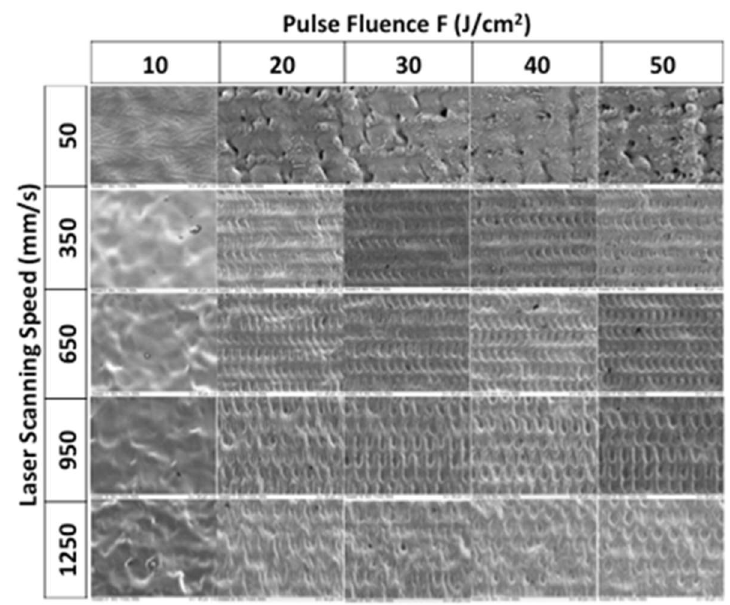
Figure 2. Surface topography of Titanium after laser ablation at varying pulse fluence and laser scanning speed.